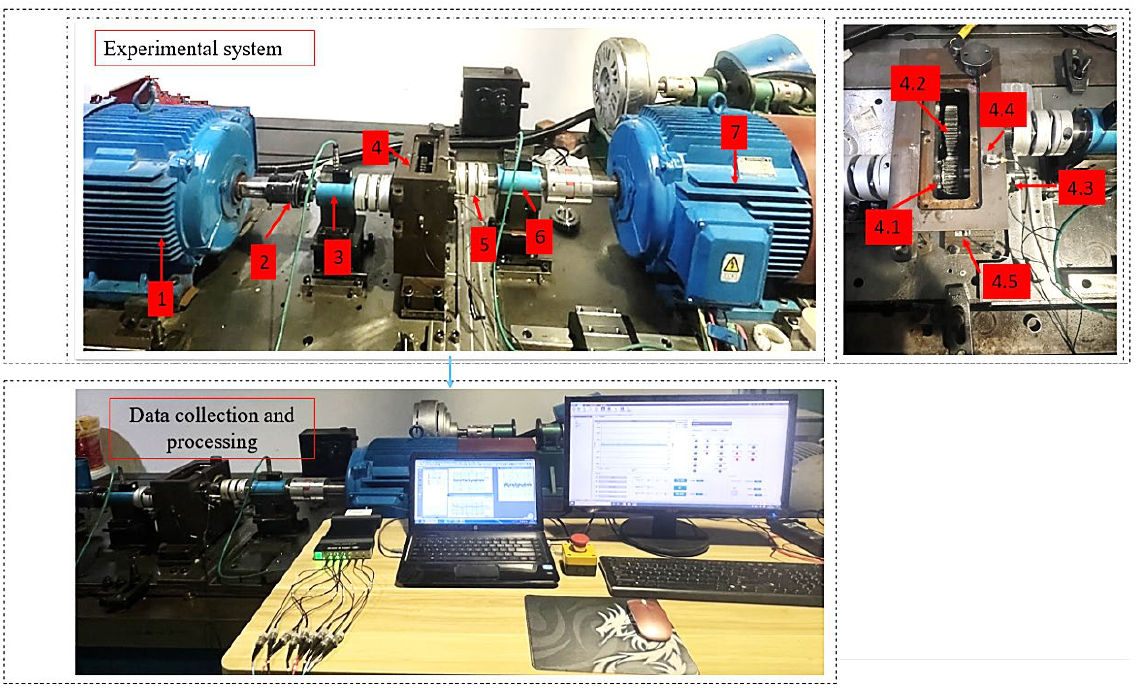
Figure 6. Experimental setup. 1–7: Active motor; 2–5: Coupling; 3–6: Torque speed sensor; 4: Gearbox; 4.1: drive gear; 4.2: driven gear; 4.3, 4.4, and 4.5: Three-direction acceleration sensor.